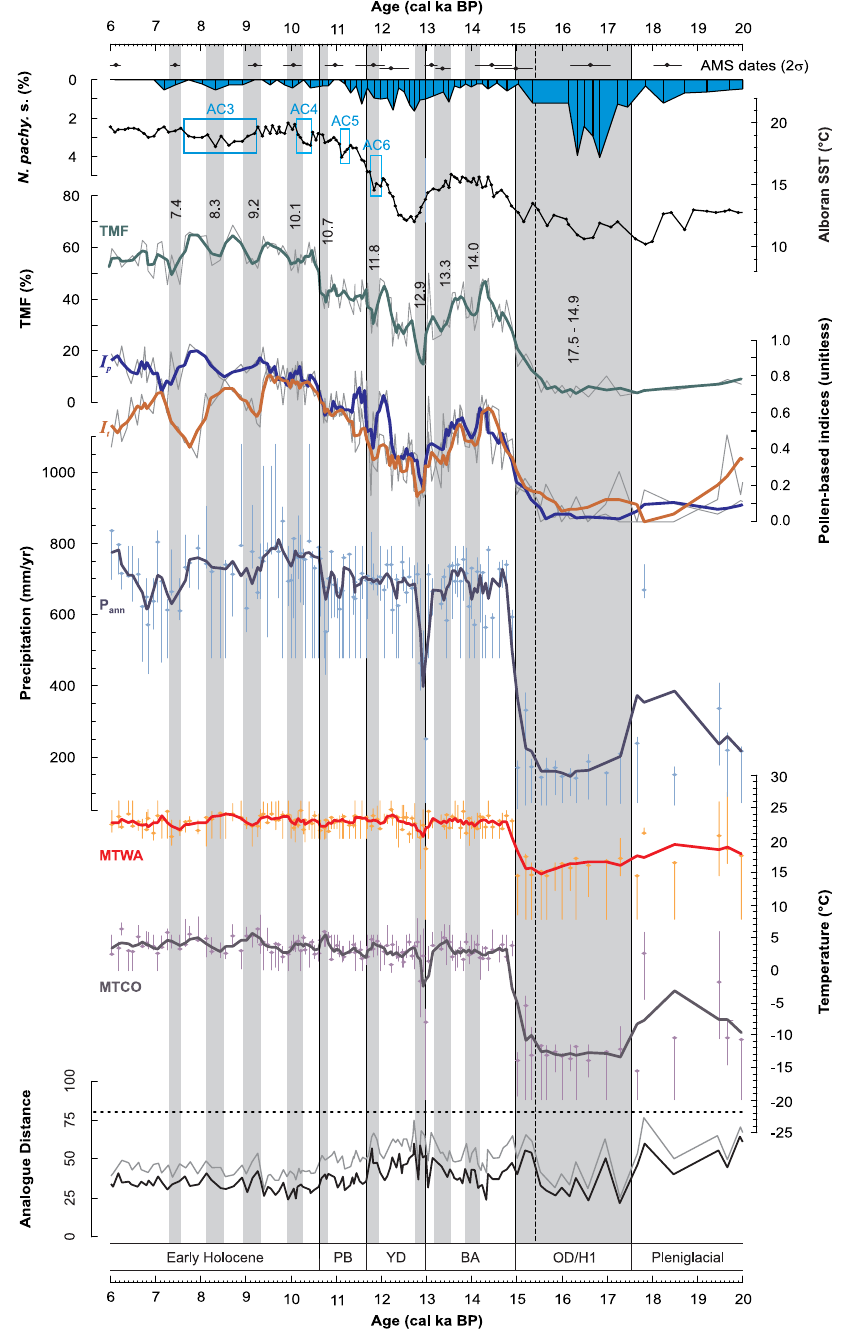
Fig. 5. Marine and terrestrial climatic tracers and pollen-based MAT climate reconstructions for the last deglaciation in core MD95-2043, plotted against age. Cold-water foraminifer N. pachyderma s. abundances and alkenone SST reconstruction from Cacho et al. (1999) shown with the positions of Alboran Sea cooling events (AC3-6), as defined in Cacho et al. (2001). Pollen percentages for temperate Mediterranean forest (TMF) taxa and curves for I t and I p are shown (raw values and 3-point moving average). Grey bars indicate multi-centennial-scale TMF declines, labelled with the central age estimate of the interval (in cal kaBP). Dashed vertical line marks the earliest signs of forest expansion during the glacial-interglacial transition (see Sect. 5.1.2). MAT reconstructions are shown for annual precipitation (P ann ), mean temperature of the coldest month (MTCO), and mean temperature of the warmest month (MTWA). MAT reconstructions show the central estimate for each sample with error range, and a 3-point moving average curve. The analogue distances (dissimilarity coefficient) for the nearest (black curve) and farthest (grey curve) of the ten best modern analogues are shown; the dotted line indicates the Monte-Carlo cut-off value for acceptable